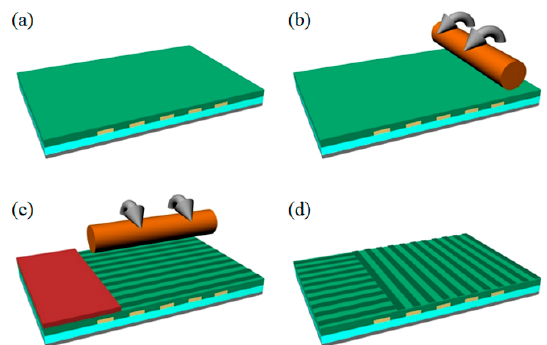
Figure 4. Schematic of the multi-rubbing process for two domains of the initial LC alignments on patterned ITO substrates to enable the ECB LC mode on the common slit for the phase changing of the interference patterns and the TN LC mode on the switching slits for changing the spatial frequency of the projected fringes: ( a ) spin-coating of the LC alignment layer; ( b ) the first rubbing process over the whole area; ( c ) the second rubbing process after the formation of the patterned passivation layer with photoresistor where the rubbing direction is orthogonal to the first rubbing direction; and ( d ) the final multi-rubbed LC alignment layer for the top substrate of the DFPG device, prepared after removing the passivation layer.